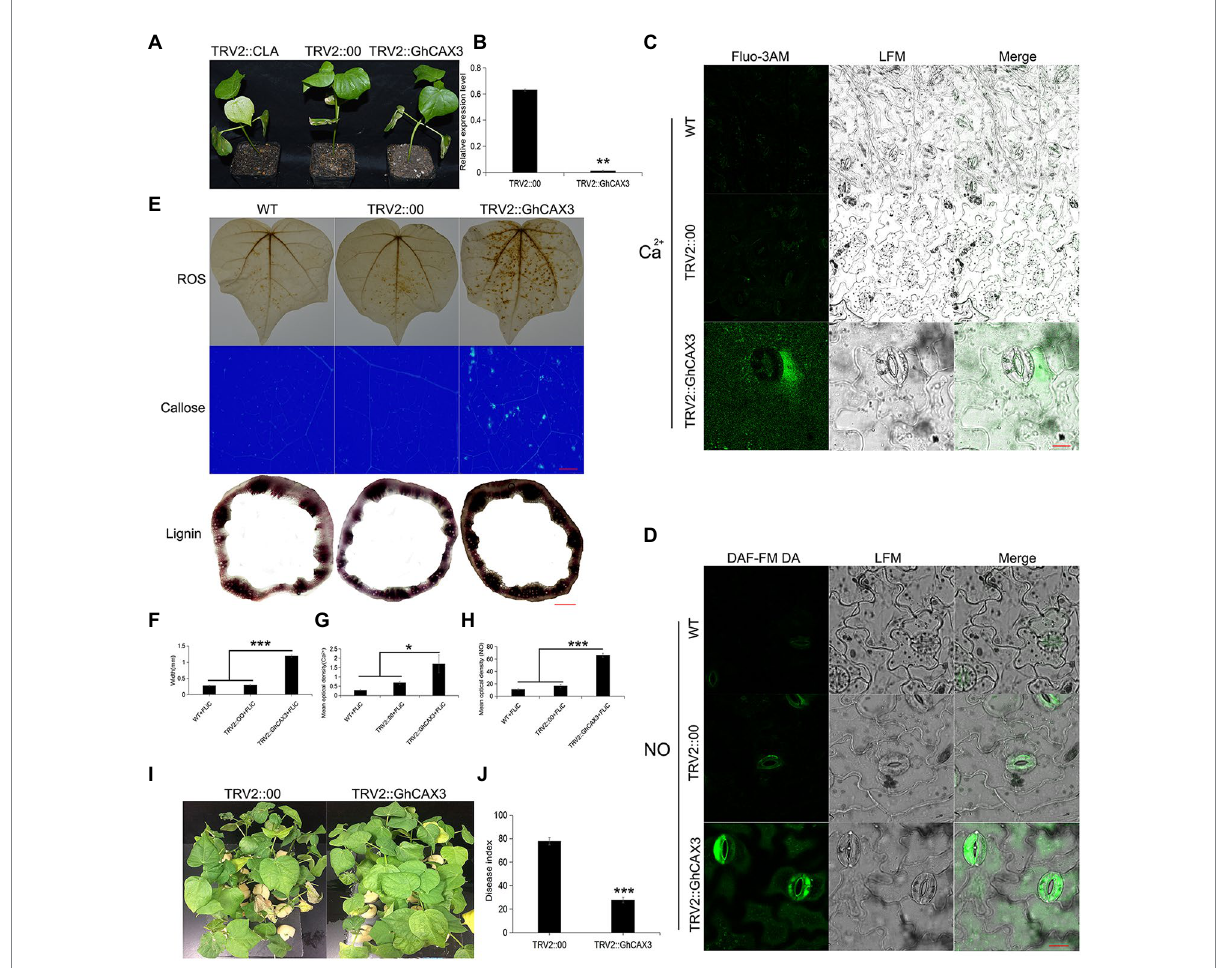
FIGURE 7 Anti-disease substances increase after the silencing of GhCAX3 . (A) Imaging of plants transformed with TRV2::GhCAX3 at 10 days after gene silencing; TRV2::CLA served as the positive control, and TRV2::00 was the negative control. (B) GhCAX3 gene silencing efficiency. (C) Intracellular Ca 2+ content of cotton after GhCAX3 gene silencing. (D) Intracellular NO content of cotton after GhCAX3 gene silencing. (E) ROS, callose, and lignin contents after GhCAX3 gene silencing. (F) Determination of the lignin content. (G) Quantification of intracellular Ca 2+ in cotton after GhCAX3 gene silencing. (H) Intracellular NO quantification in cotton after GhCAX3 gene silencing. (I) Detection of disease resistance after GhCAX3 gene silencing. (J) Investigation of disease index after GhCAX3 gene silencing. The data represent the means ± SDs; n = 3 (* p < 0.05; ** p < 0.01; *** p < 0.001; t test). Bars (C,D) = 50 μ m. Bars (E) = 2000 μ